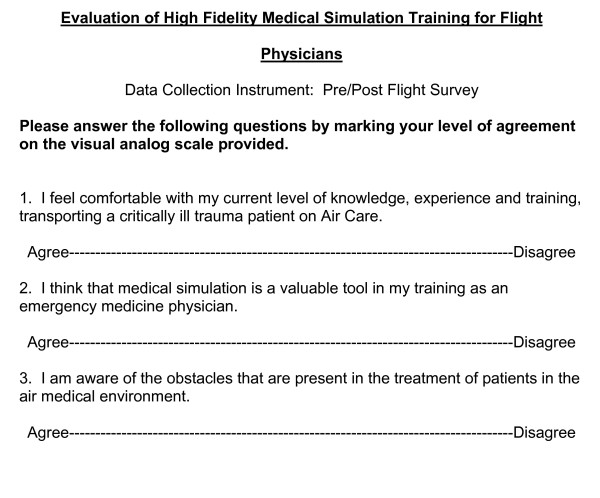
Pre- Post-Simulation Questionnaire.